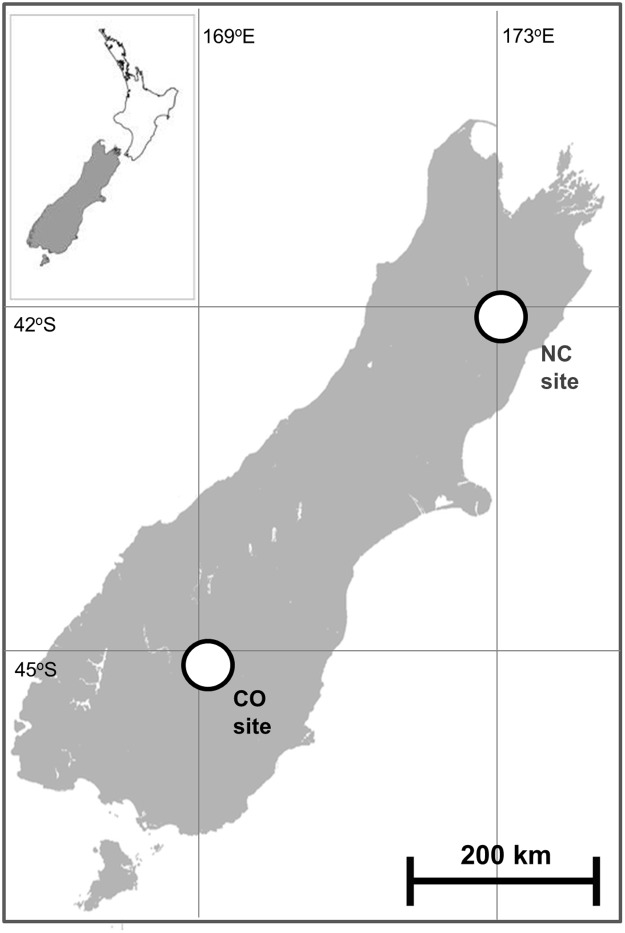
Outline map of the South Island of New Zealand, indicating the location in the South Island of the Central Otago (CO) and North Canterbury (NC) study sites.